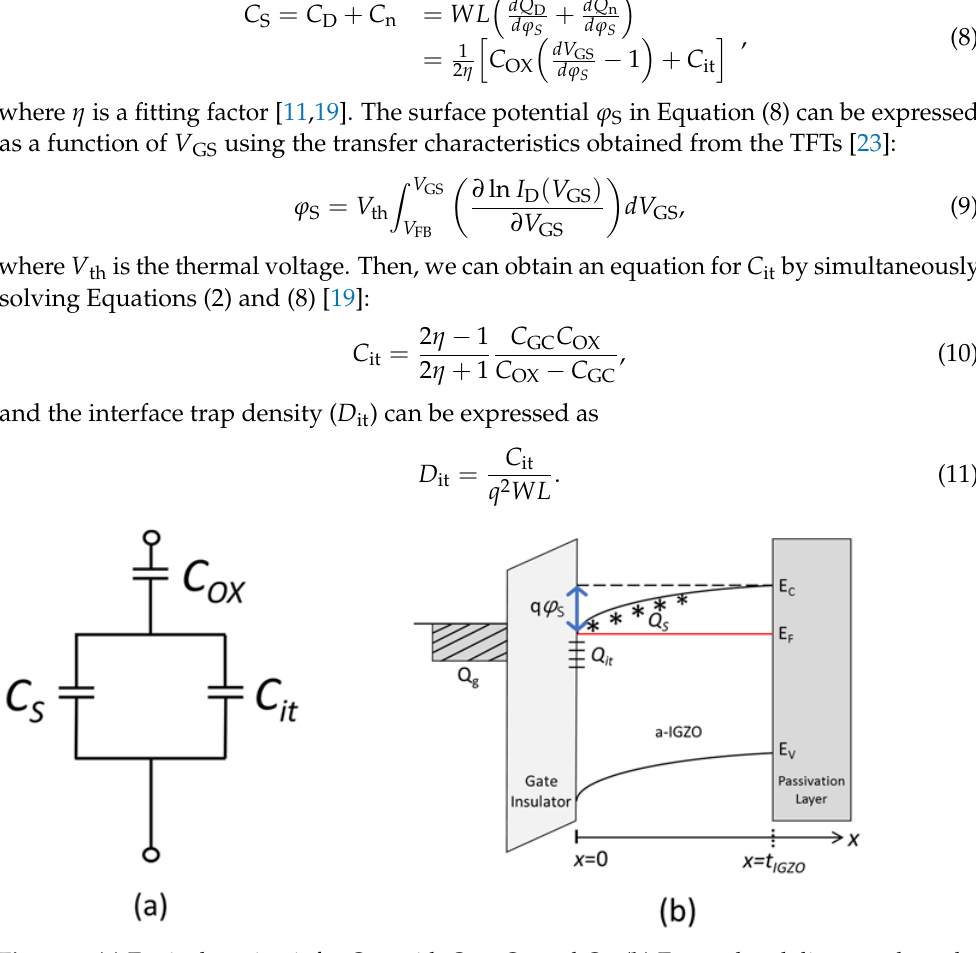
Figure 5. ( a ) Equivalent circuit for C GC with C OX , C S , and C it ; ( b ) Energy band diagram along the channel depth direction.